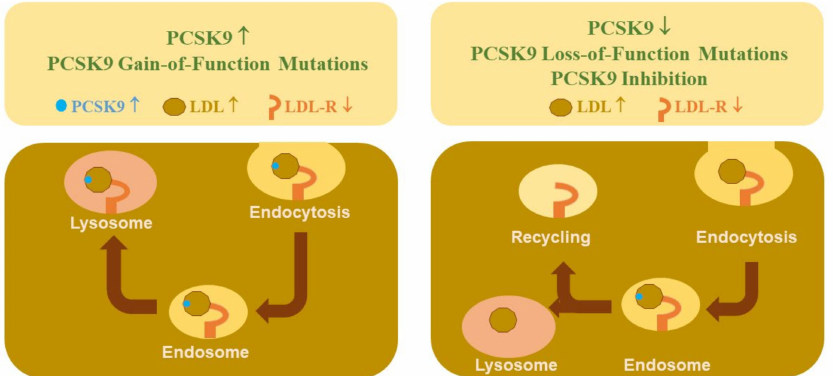
Figure 1. Regulation of LDL and hepatic LDL-R levels by PCSK9. LDL bound to the LDL-R is taken up by endocytosis, LDL is degraded in the lysosome and LDL-R is recycled. Binding of PCSK9 to the LDL–LDL-R complex induces lysosomal degradation of the LDL-R. High PCSK9 levels and PCSK9 gain-of-function mutations favor LDL-R degradation leading to low hepatic LDL-R protein and high LDL levels in plasma. Low PCSK9 levels, loss-of-function mutations and PCSK9 blockage favor LDL-R recycling and lead to higher abundance of the hepatic LDL-R and improved clearance of circulating